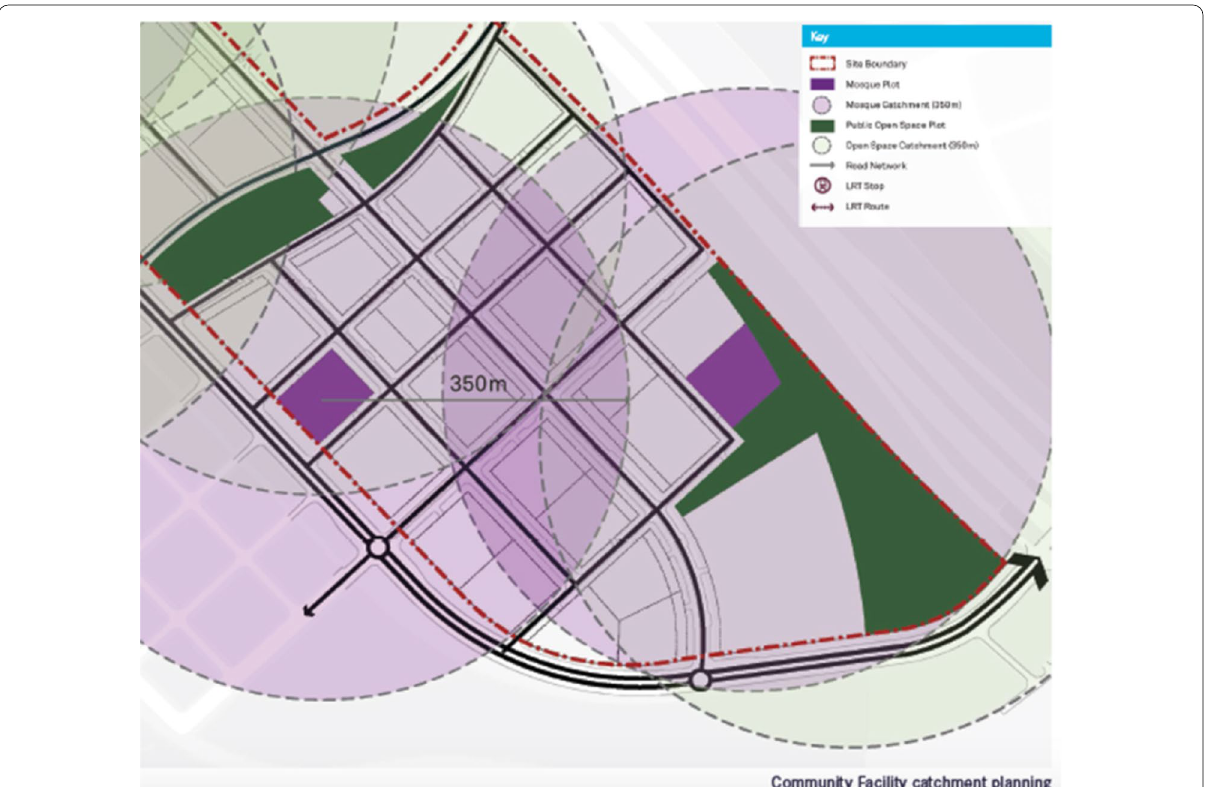
Fig. 3 Catchment distance for neighborhood facilities in Abu Dhabi National Housing Guidelines for Integrated Communities ( Source: Abu Dhabi Housing Authority